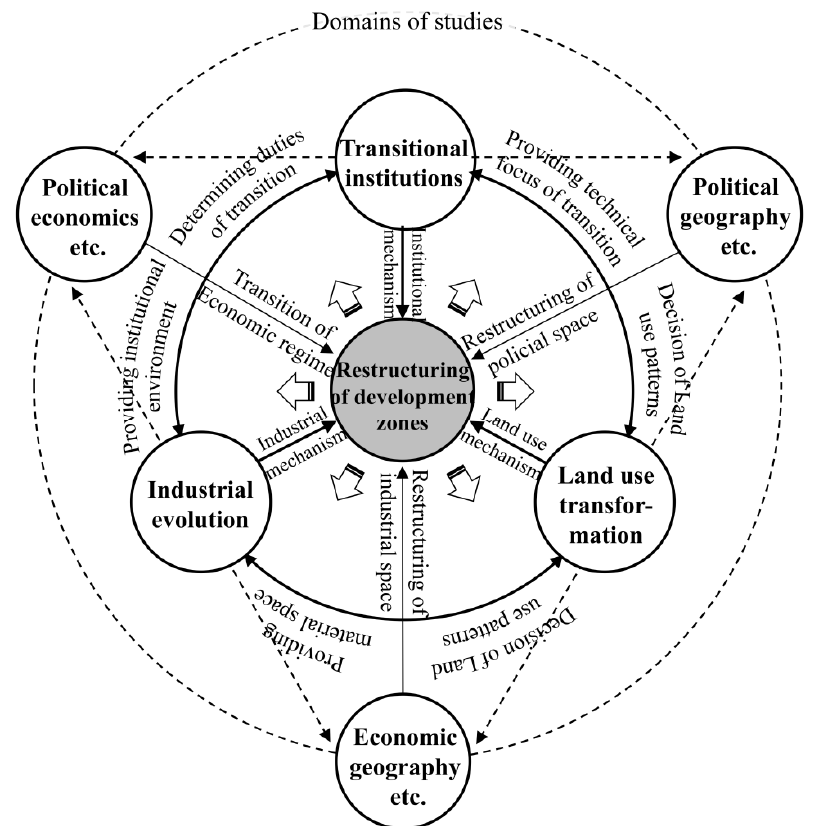
Figure 1. Conceptual framework of restructuring for growth in development zones. Source: Prepared by the authors.